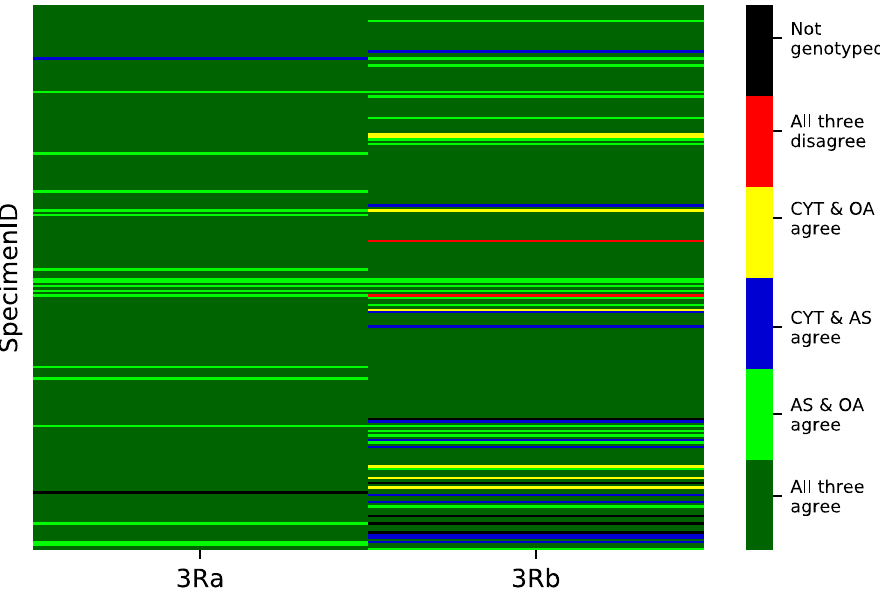
Figure 3. Concordance heat map of genotypes imputed by cytogenetics (CYT), OpenArray (OA), and amplicon sequencing (AS). Each row is an individual mosquito, and the columns (inversions 3Ra and 3Rb) report the degree of agreement among genotyping approaches for the inversions in each mosquito. Dark green represents 3-way genotypic concordance; light green, concordance between AS and OA; blue, concordance between CYT and AS; yellow, concordance between CYT and OA; red, 3-way discordance; black, missing data for at least one genotyping approach.